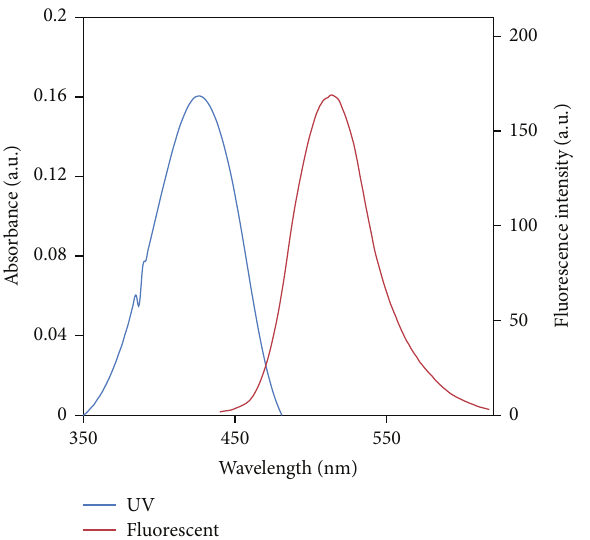
Figure 1: Absorption and fluorescence spectra of 1 (0.92 𝜇 M) in acetonitrile.